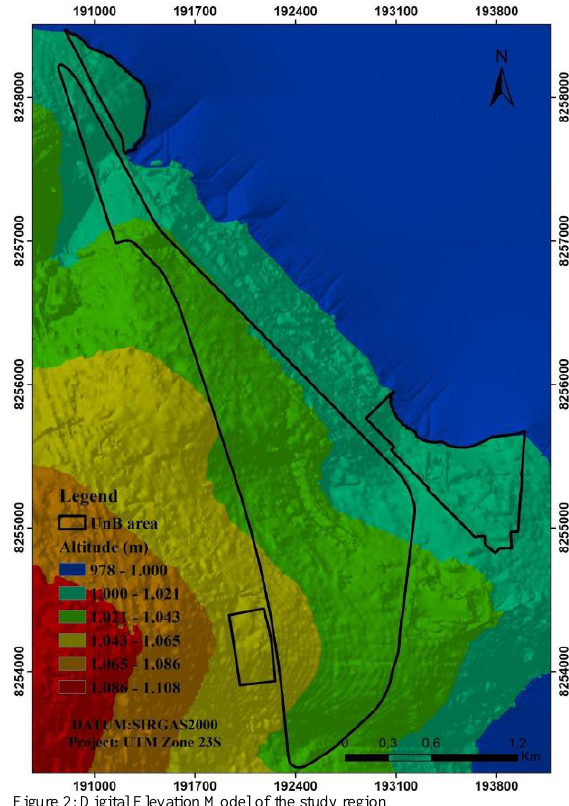
Figure 2: Digital Elevation Model of the study region Source: The Authors The flowchart with the main steps of the methodology is shown in Figure 3.